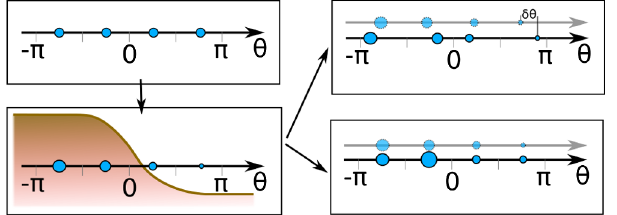
FIG. 2. Schematic description of the 1D shot-noise modeling methods. First step: unperturbed uniform particle loading (top- left). Optional step when the longitudinal beam profile varies within a wavelength: mean charge weight based on beam profile (left-bottom). Shadowed curve represent a longitudinal beam profile. Second step: temporal coordinate perturbations (top- right) or charge weight perturbations (bottom-right). The trans- parent particles represent the particles before